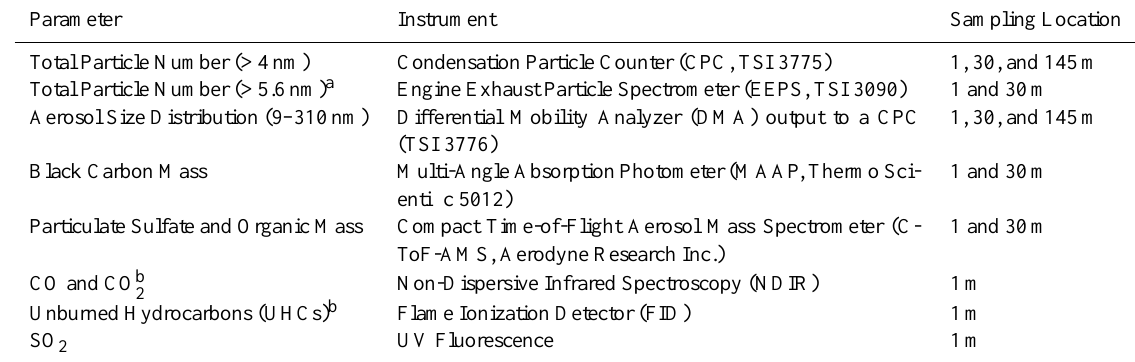
Table 1. Measurements used for analysis.